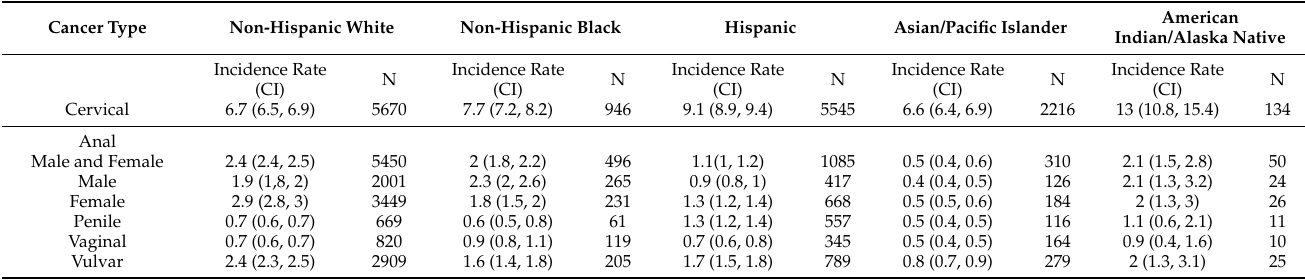
Table 5. Age-adjusted incidence rates 1 of cervical, anal, penile, vaginal, and vulvar 2 , 2009–2018 CA. Cancer